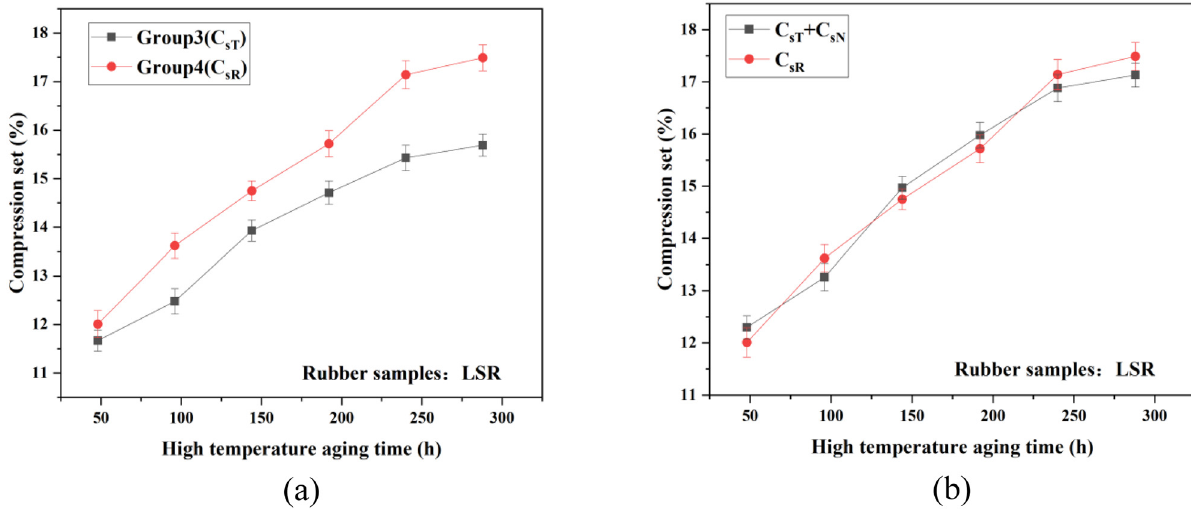
Figure 10: Compression set test results of LSR of ( a ) C sT and C sR , and ( b ) C sT + C sN and C sR .